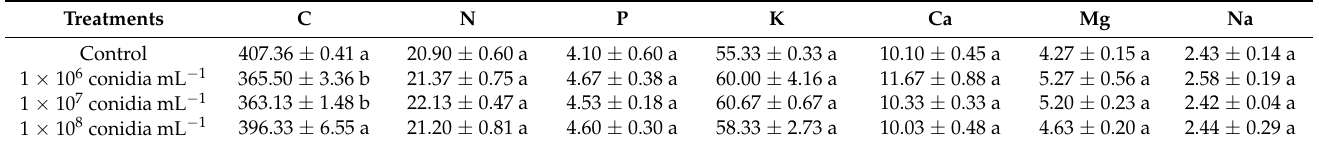
Table 5. Effects of inoculating lettuce plants ( Lactuca sativa ) with different conidial concentrations of Beauveria bassiana on tissue macronutrients contents (g kg − 1 ) ( n = 12).